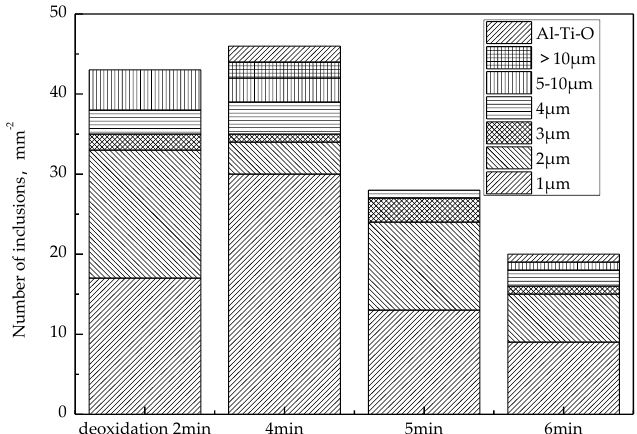
Figure 7. Change of inclusions after RH deoxidization.